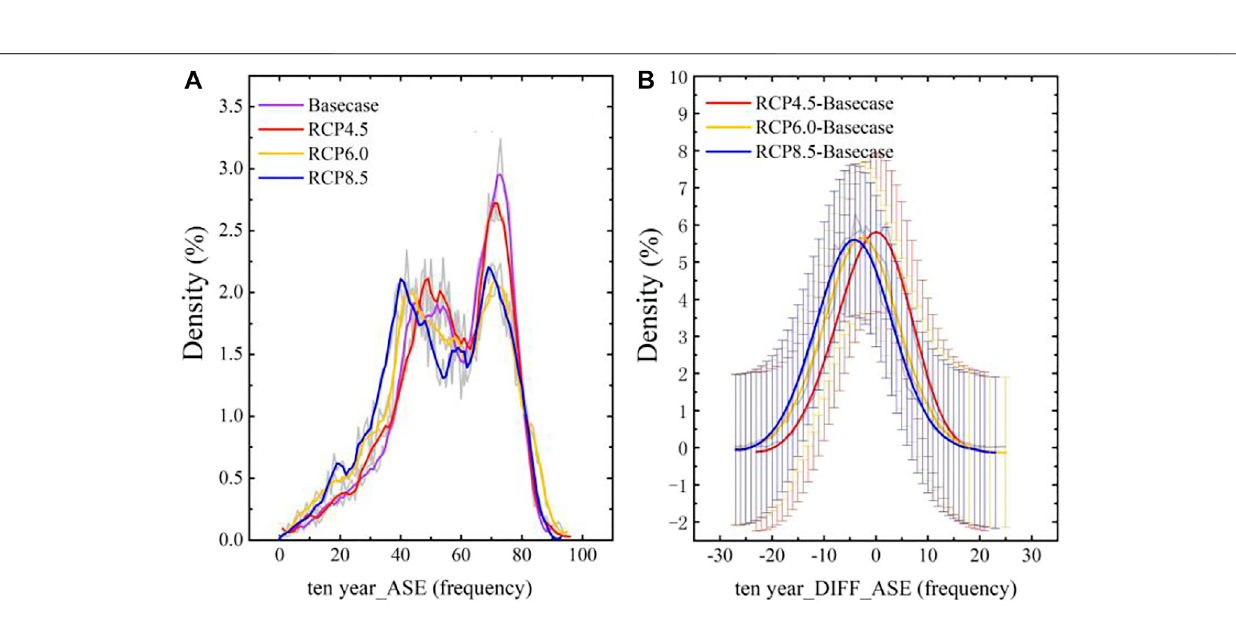
FIGURE 6 | Probability distribution of ASE (A) and ASE difference (2046 – 2055 relative to 2006 – 2015) (B)